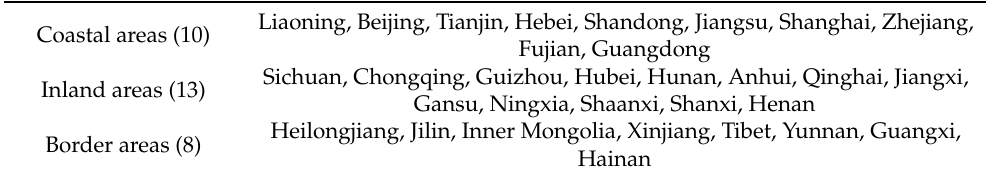
Table 5. Three new regions and their scope.